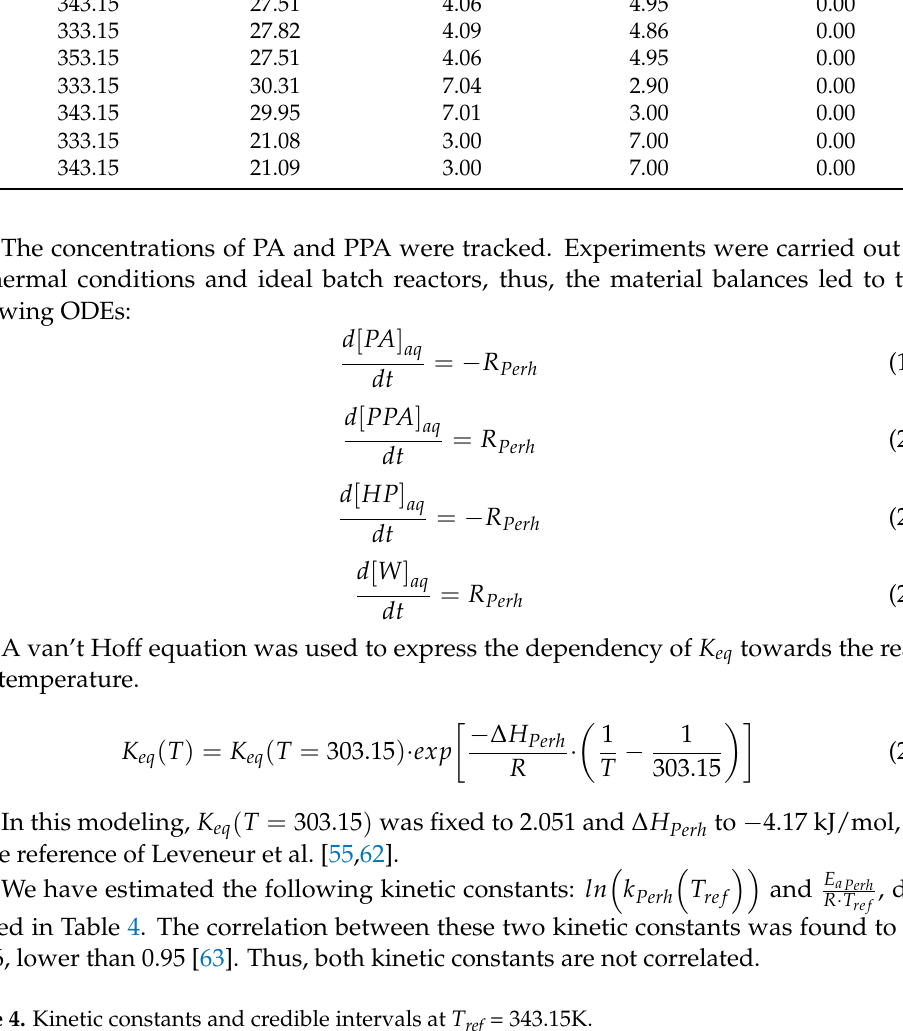
Table 4. Kinetic constants and credible intervals at T ref = 343.15K. Units